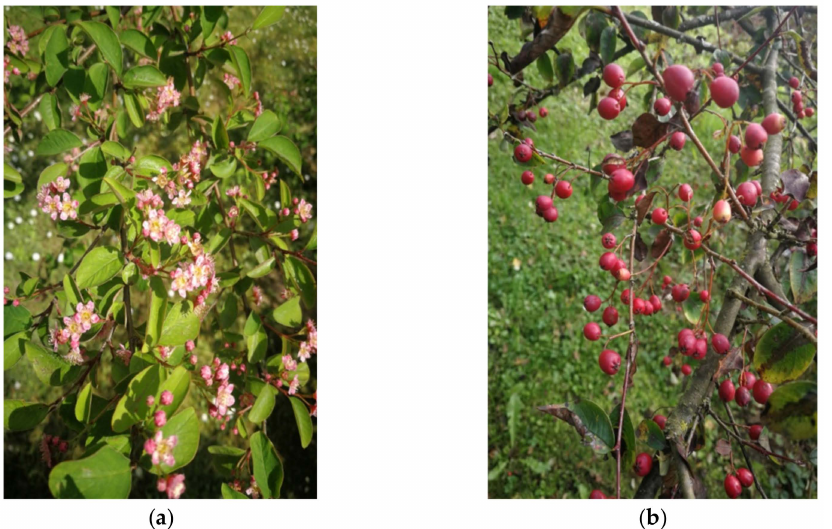
Figure 10. C. roseus in the UMCS Botanical Garden of Maria Curie-Skłodowska University in Lublin taken in May ( a ) and in September ( b